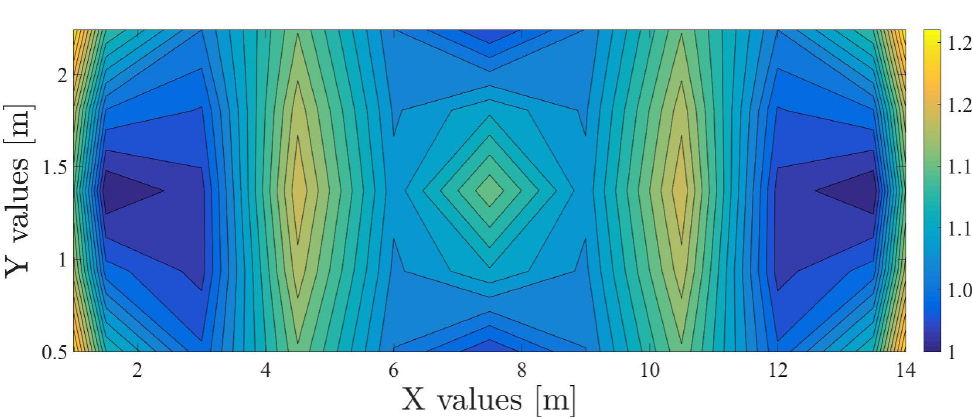
Figure 19. Mapping of the residual height as a function of the impact position on the net (m).